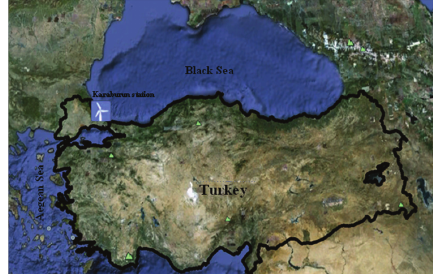
Figure 2: The location of the Karaburun wind